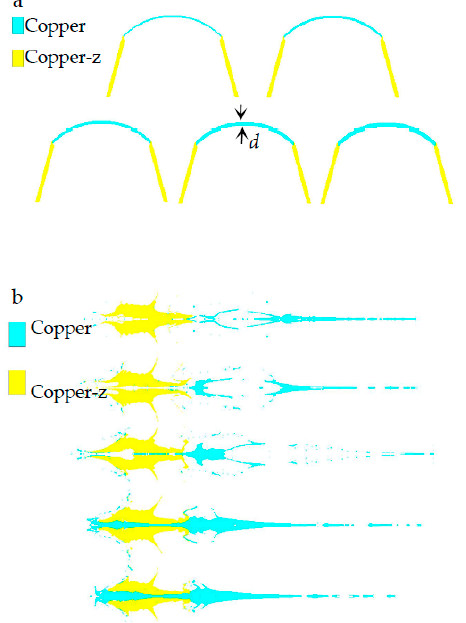
Figure 11. Jet shape formed by different vertex wall thicknesses: ( a ) SCS liner; ( b ) Jet.